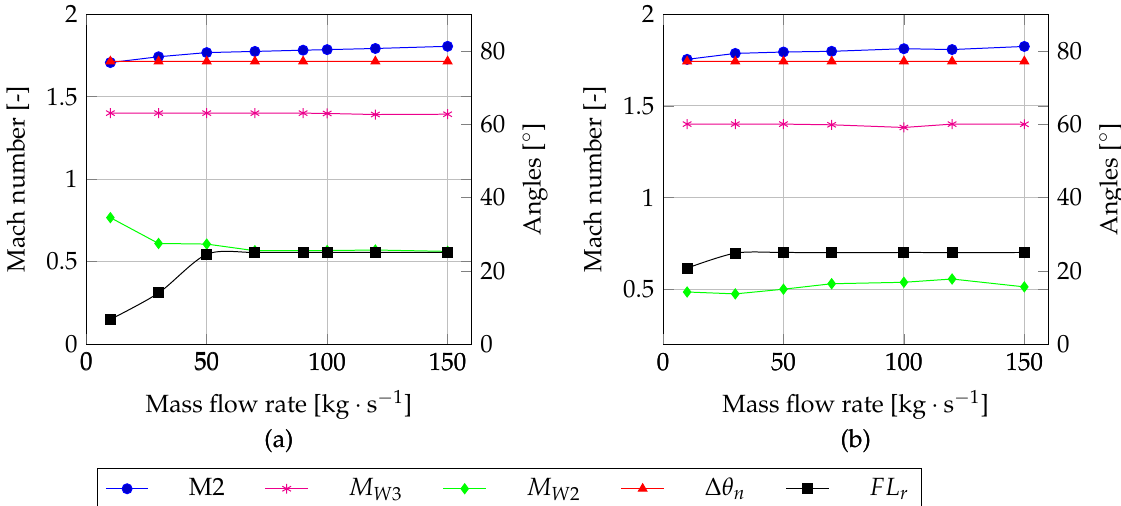
Figure 10. Angles and Mach numbers for the optimal geometric configurations for π = 20 as a function of mass flow rate: ( a ) constant rotational speed and ( b ) optimized rotational